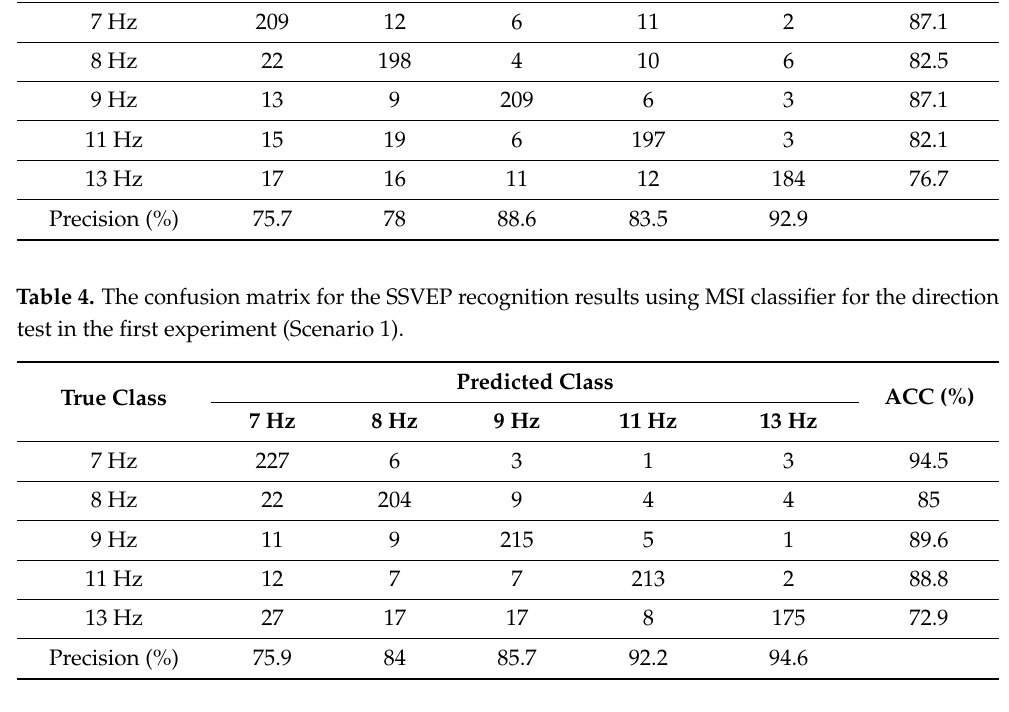
Table 5. The confusion matrix for the SSVEP recognition results using MSI classifier for the room information test in the first experiment (Scenario 2).